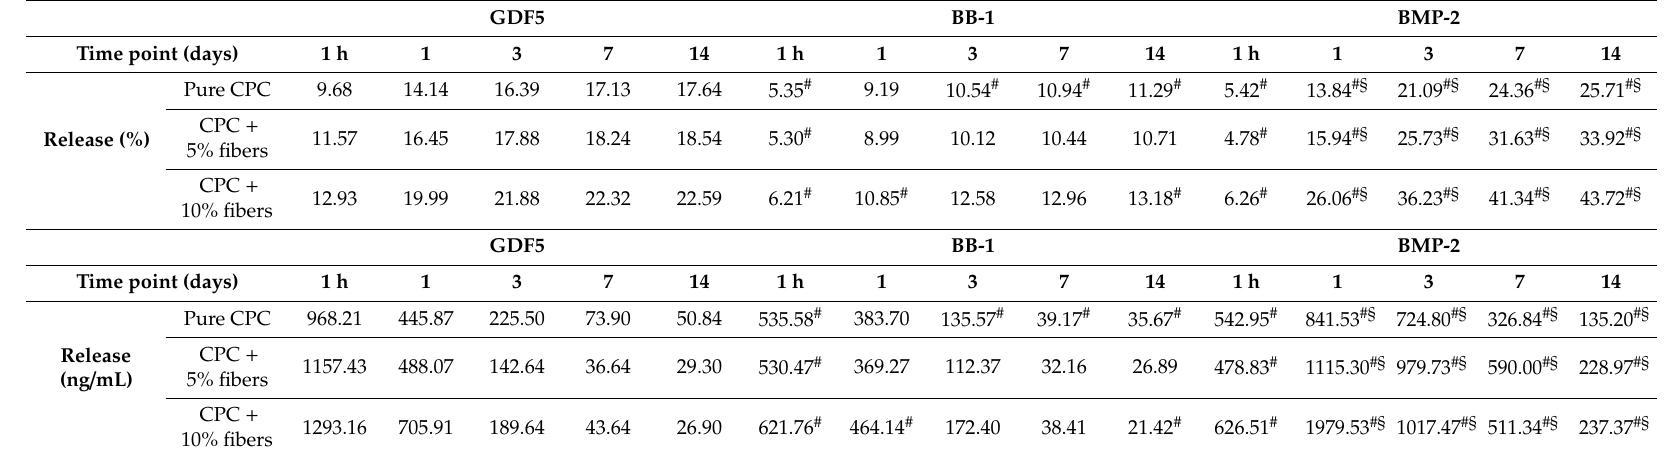
Table 2. Di ff erences among the release of the di ff erent BMPs from ground pure CPC and CPC ± PLGA fibers (GDF5, BB-1, BMP-2; n = 3 experiments each); # p ≤ 0.05 vs. GDF5; § p ≤ 0.05 vs. BB-1; note: di ff erences among the di ff erent release time points are only shown in Figure